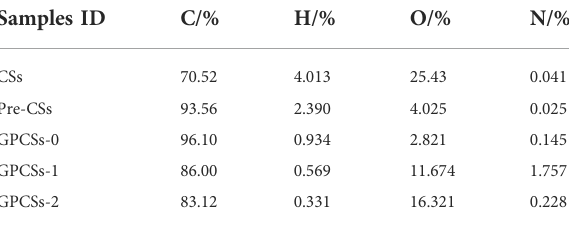
TABLE 1 Elemental analysis of hemicelluloses-based carbon spheres. Samples